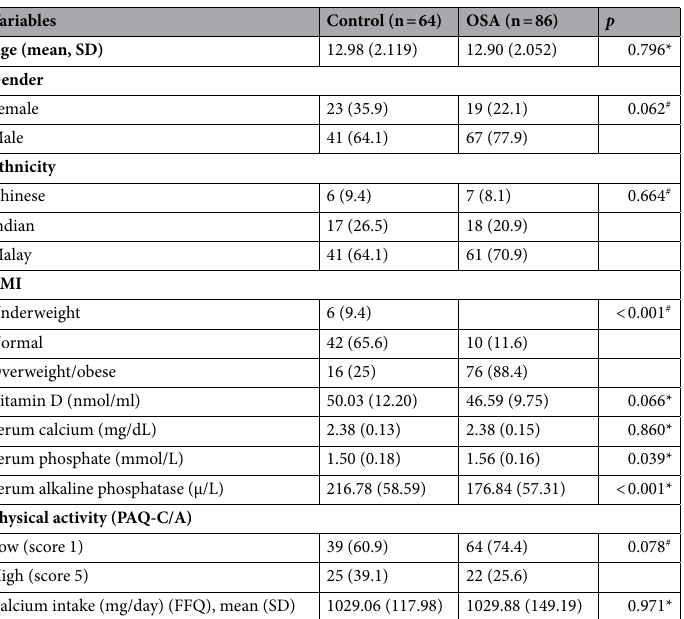
Table 1. Demographic and baseline characteristics for control and OSA groups (n = 150). All continuous variables skewness and kurtosis were in the range between − 2 and 2 hence the data were represented by mean (SD) where SD standard deviation, t , student t-test*; x 2 , chi square # ; p p